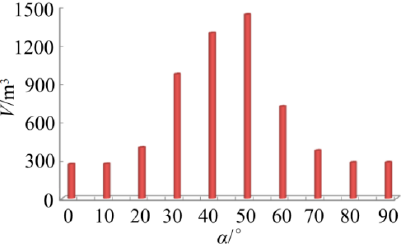
Figure 3. The relationship between α and the range of the plastic zone (Plan 1).